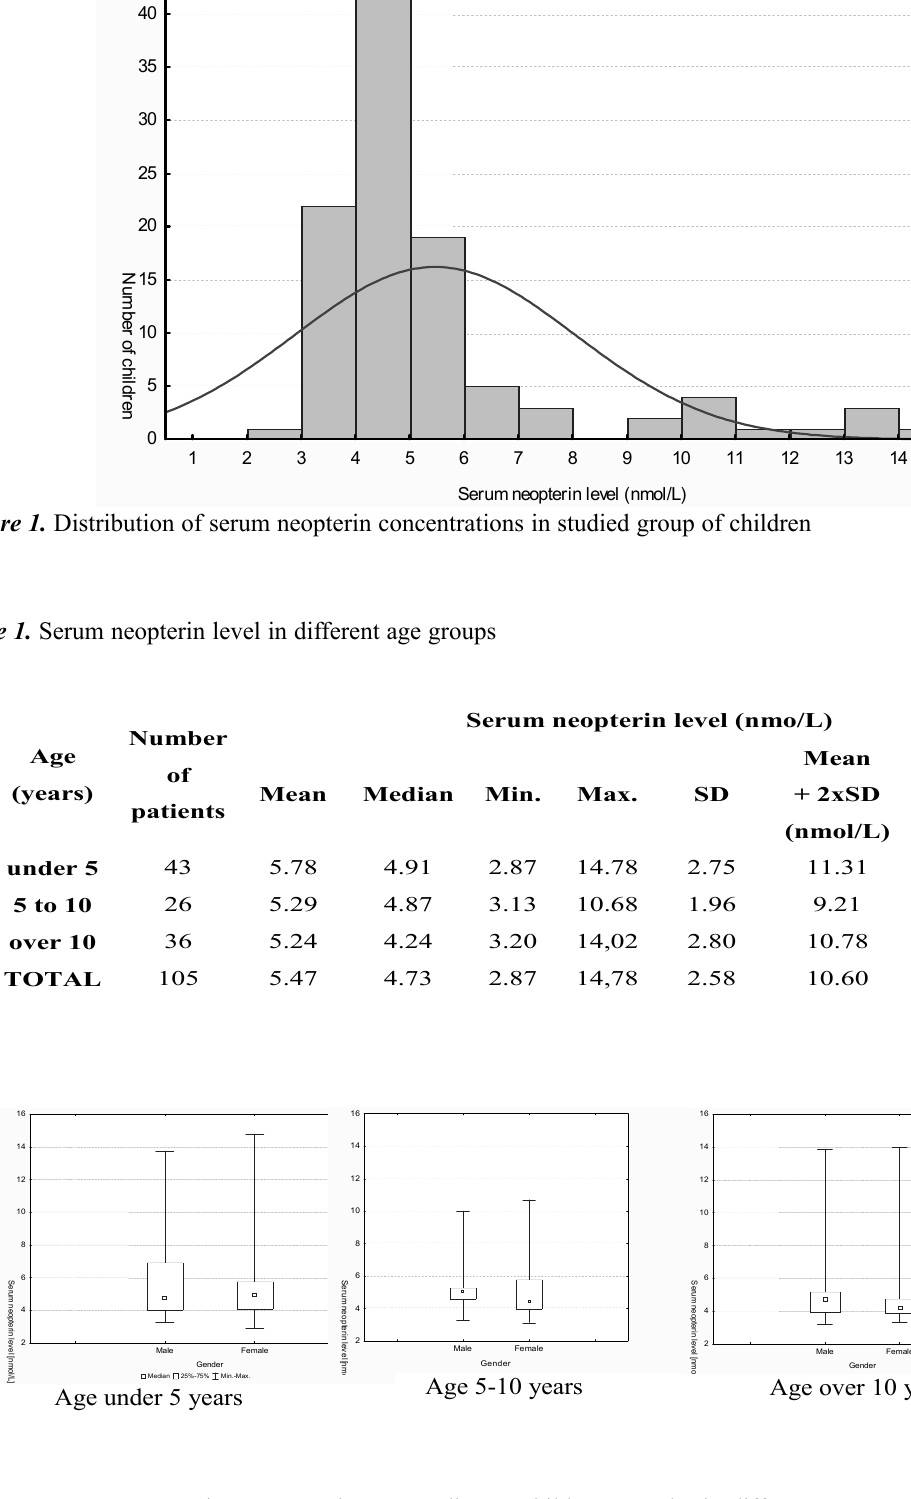
Figure 2. Serum neopterin concentrations according to children's gender in different age groups (graphs show median = dot, 25 th - 75 th percentiles = box, range =